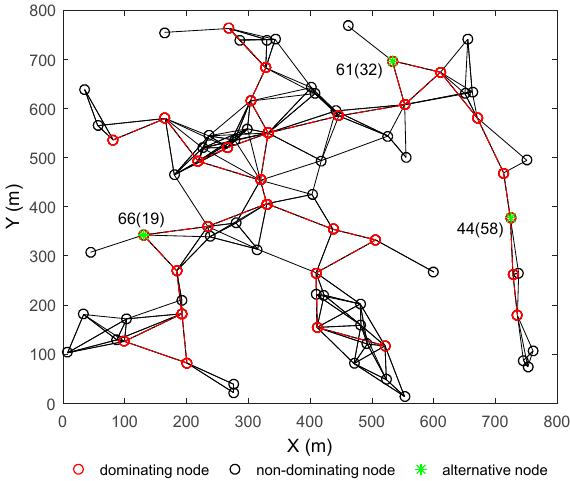
Figure 7. The network topology after restoring the connectivity for the three abnormal nodes.